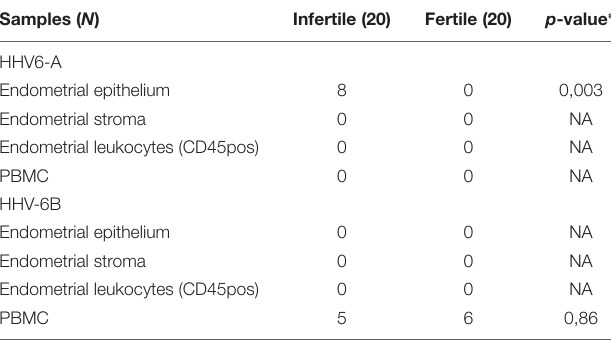
TABLE 2 | HHV-6 DNA results in peripheral blood mononuclear cells (PBMC) and endometrial biopsies. Samples ( N ) Infertile (20)